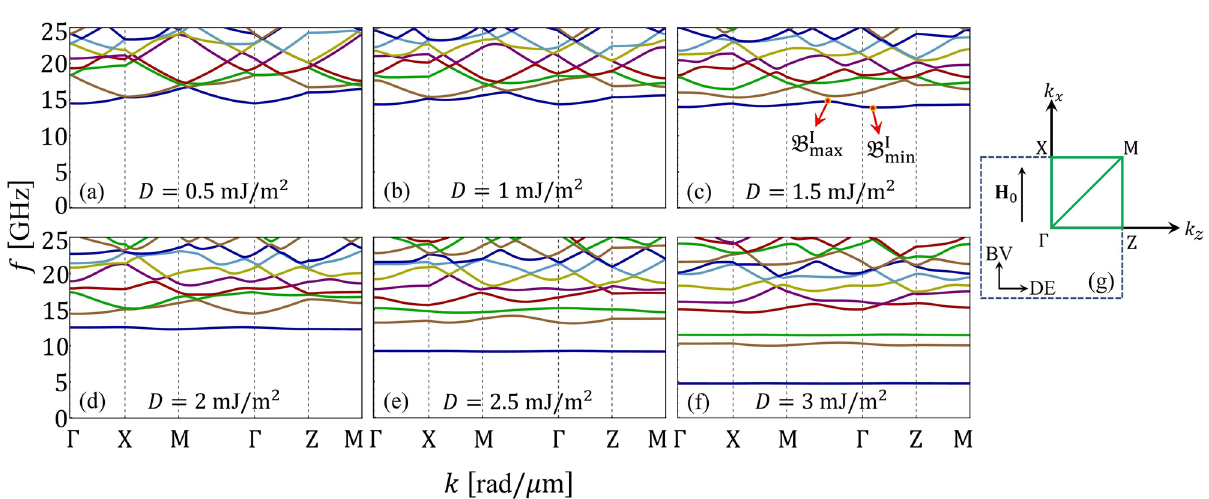
Figure 3. ( a – f ) Show the band structures of a two-dimensional chiral magnonic crystal on the reduced Brillouin zone, where the path followed by the wave vector is shown in ( g ). Heavy-metal islands are considered for inducing a periodic Dzyaloshinskii–Moriya coupling, where a z = a x = 100 nm and w z = w x = 50 nm. The states B n max and B n min are defined in ( c ), which describe the maximum and minimum of the band n , the slope (in the f vs. k plot) is large, then the group velocity’s magnitude will also be large, while its direction is given by the sign on the slope. As an example, Fig. 4b shows the z -direction of the group velocity, v z g , of the first four low-frequency bands at point Z, ( π/ a z , 0 ), of the reduced Brillouin zone. Different values of D are considered, where one can see that v z g of the first band B I tends to zero as the constant D increases. Similar behavior is noted on the band B III , but a different magnitude of D is required to reach the flat property. We can note that for some specific values of the DM constant, the group velocity becomes abruptly zero, which is related to the states where a maximum or minimum matches with the point ( π/ a z , 0 ). Moreover, the color change in some parts of Fig. 4b is correlated with the crossing between modes, which can happen at